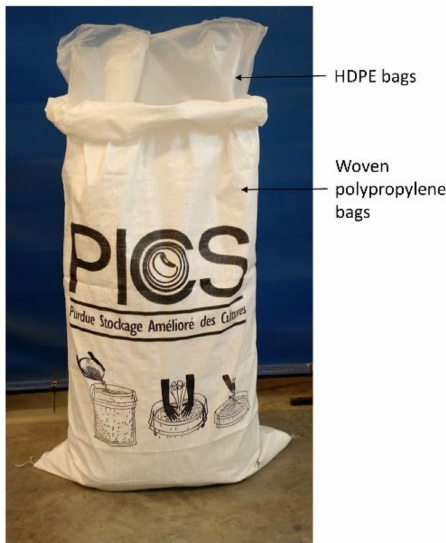
Figure 3. Triple-bagging hermetic storage for developing